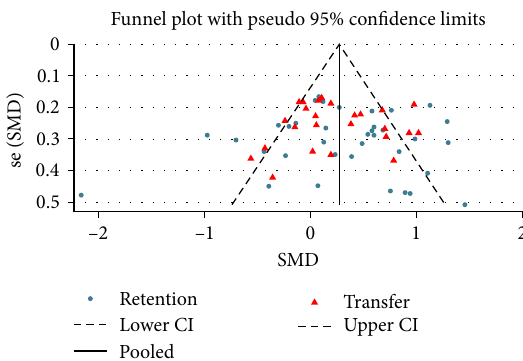
F IGURE 4: Funnel plots of publication bias